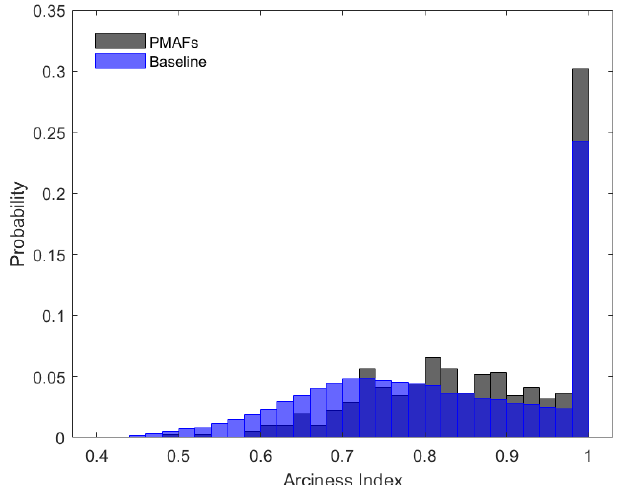
Figure 5. Arciness values during PMAF events (black) and daytime baseline (blue). The baseline is determined by taking all arciness values from the noon sector (09:00–15:00MLT) of the days in the first event list, excluding times during which PMAFs